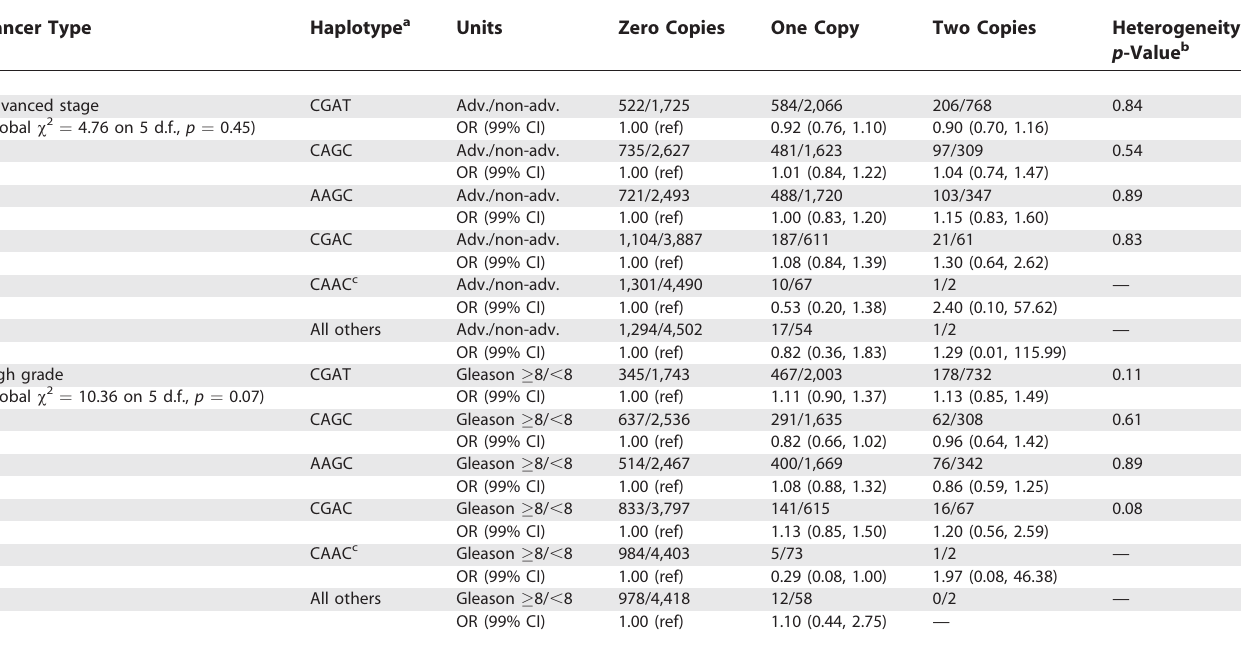
Table 6. HSD17B1 Haplotypes and Risk of Advanced Stage ( (cid:1) C) and High-Grade (Gleason (cid:1) 8) Prostate Cancer among All Cases Cancer